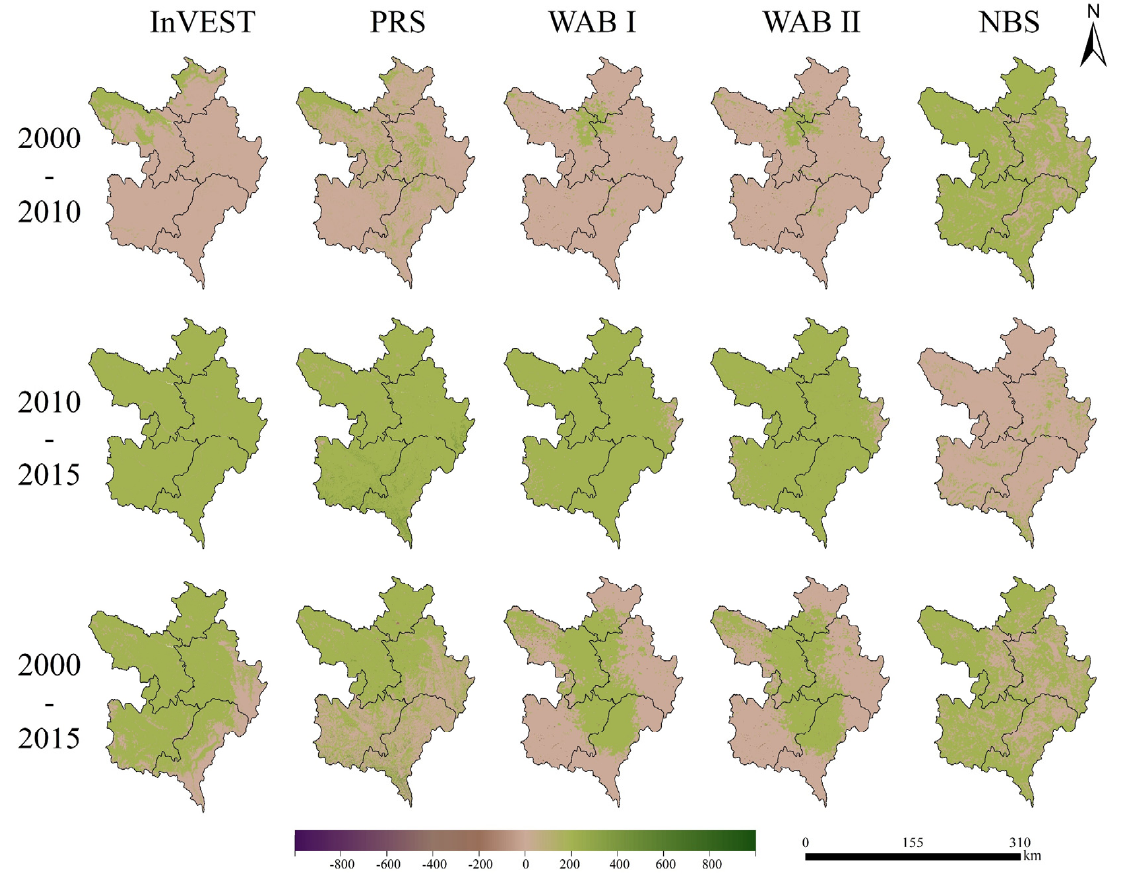
Figure 7. The spatial–temporal variations in WR service by five models in different periods. The units for models except the NBS model are mm/grid, and dimensionless for the NBS model.